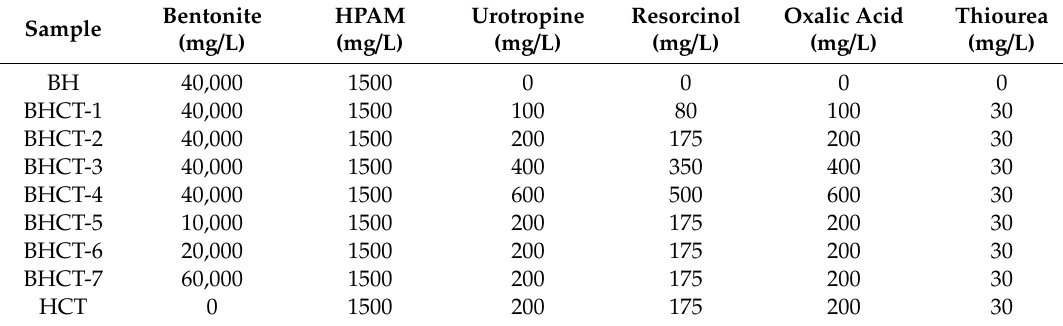
Figure 1. Preparation process of polyacrylamide / bentonite organic crosslinked composite gel. Table 1. Formulations of composite gels.